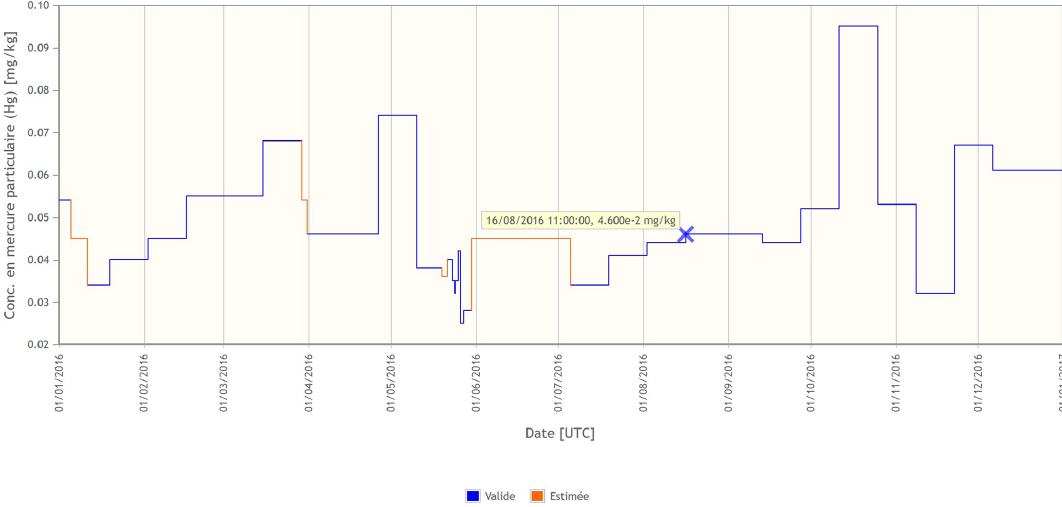
Figure 6. BDOH OSR database screenshot of the continuous time series with estimated concentration (orange) of Hg concentration at Jons in samples collected by particle